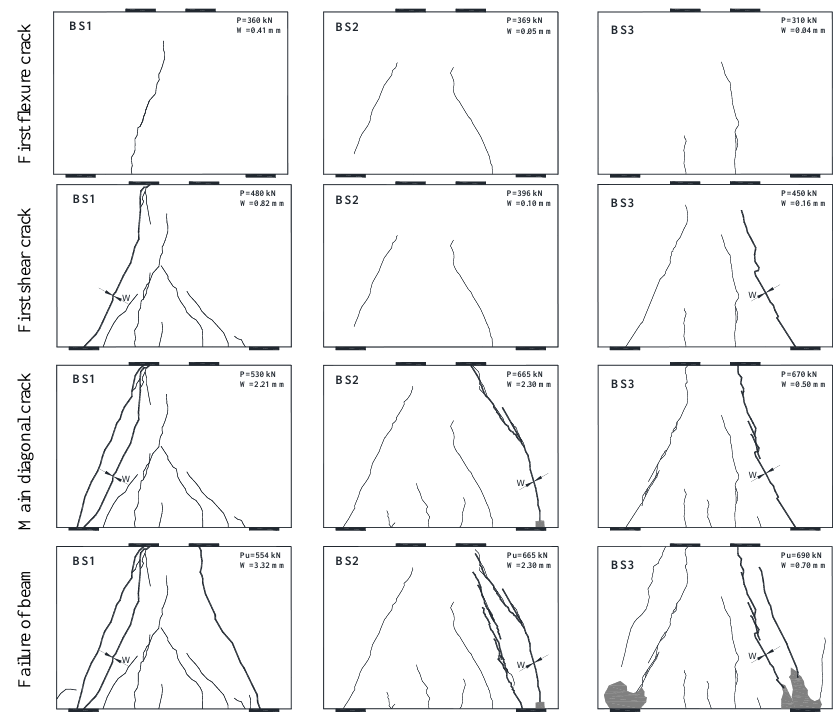
Figure 16: Crack development and mode of failure for the deep beam with steel web reinforcement.